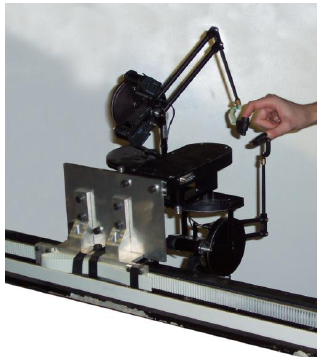
Figure 2. Prototype system “The Stoat”—Two Sensable Phantom 1.5 haptic interfaces are mounted on a linear track.